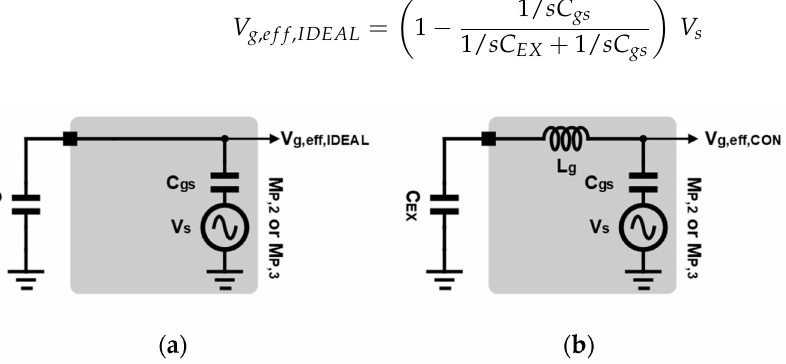
Figure 8. Equivalent circuits of power transistor with typical layout technique: ( a ) ideal case and ( b ) case considering parasitic inductance, L g